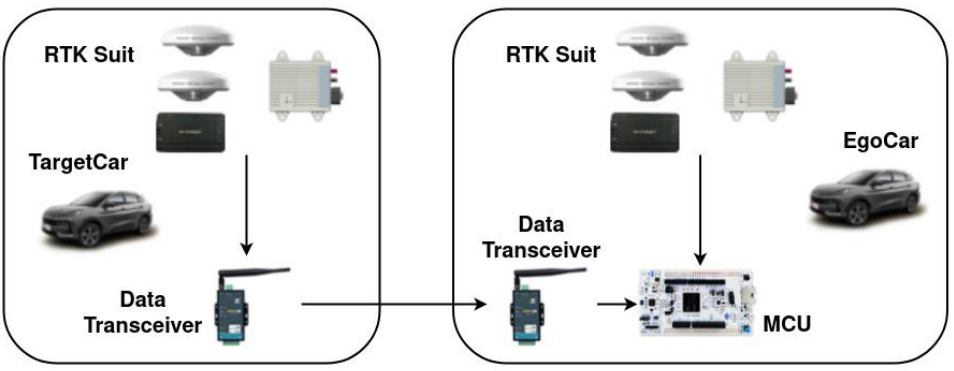
Figure 14. Validation platform.